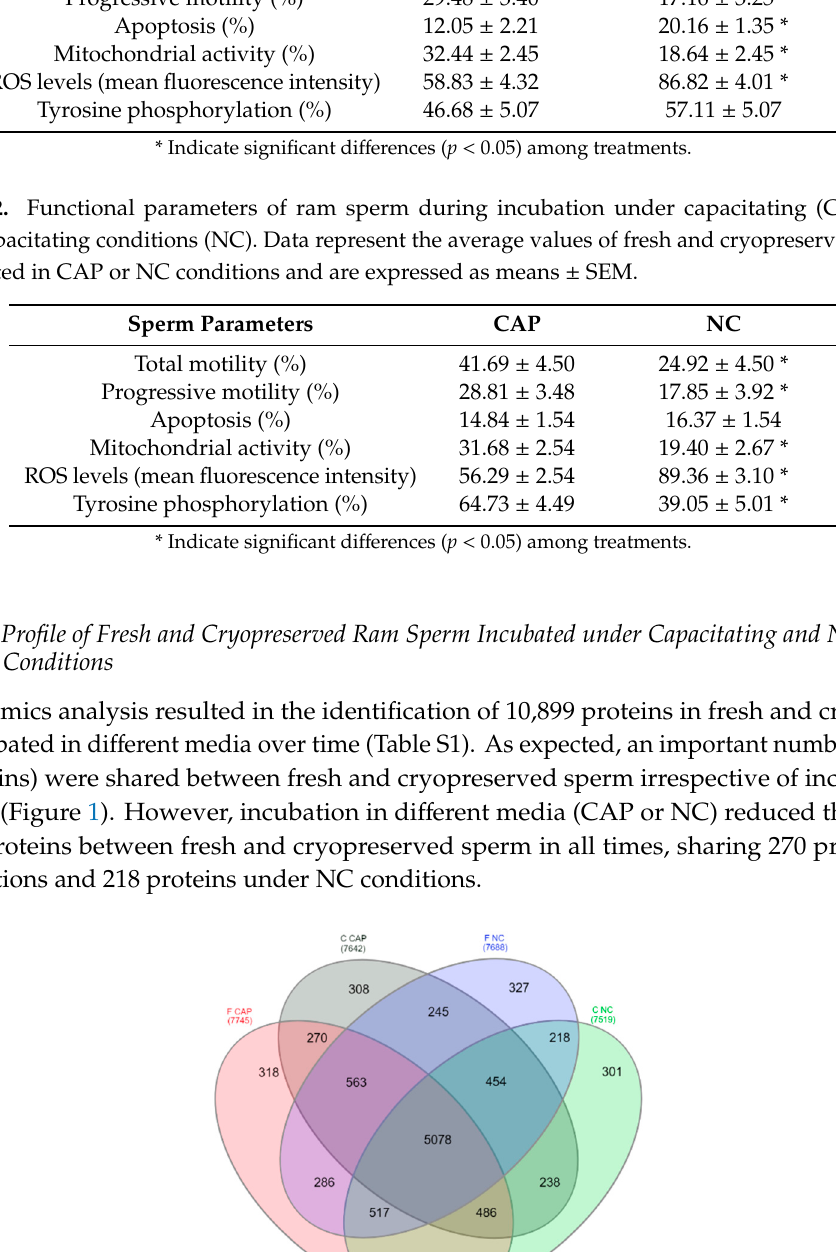
Table 1. Functional parameters of ram sperm before and after cryopreservation. Data represent the average values of fresh or cryopreserved sperm incubated in both media and are expressed as means ± SEM.